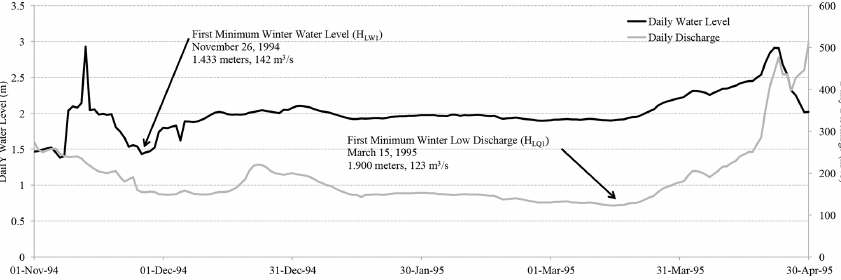
Figure 6. Daily reported water level and discharge for the Athabasca River below Fort McMurray (07DA001) for the ice-affected (B flagged) period spanning 1 November 1994 to 30 April 1995. Note that an increase in water level does not necessarily result in more discharge due to the varying hydraulic effects of ice. Figure adapted from de Rham et al.